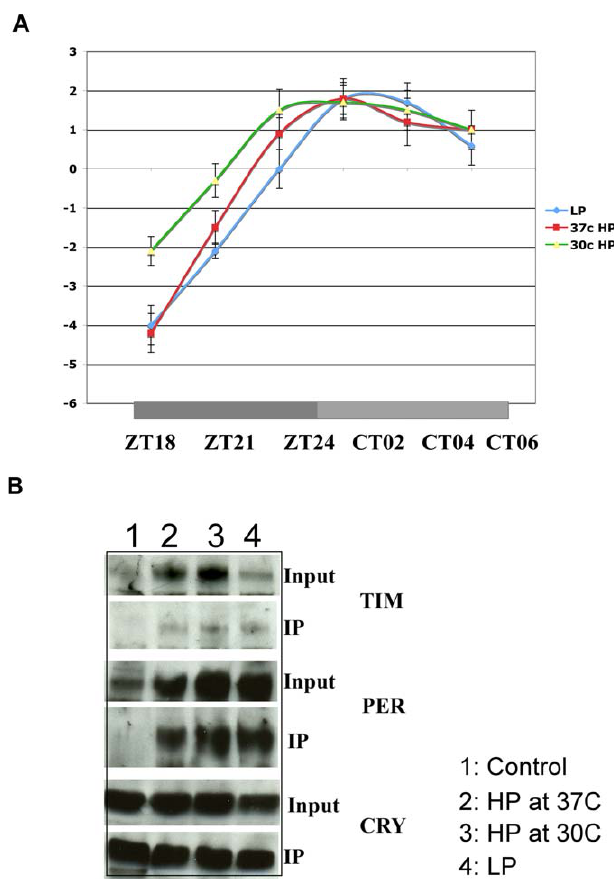
Figure 4. per L Is Hypersensitive to Heat Pulses Phase response curves are shown for per L flies, after a heat pulse at 37 8 C (square), after a 30 8 C heat pulse (diamond) or after a light pulse (circle). The experiment was performed as described in Figure 1A and repeated twice with similar results. Phase delays and phase advances are plotted ( þ /- SEM) as negative and positive values, respectively. Data were pooled from the following number of flies (each set of values referring to per L light pulsed, heat pulsed at 30 8 C or 37 8 C): control: 32, 32, 32; pulse at ZT18: 26, 32, 29; pulse at ZT21: 19, 32, 31; pulse at ZT24: 27, 31, 27; pulse at CT02: 30, 31, 22; pulse at CT04: 32, 29, 21. (B) per L ; TMC flies (see above) were entrained to 12:12 light:dark conditions and heat pulsed at 37 8 C (2) heat pulsed at 30 8 C (3), light pulsed (LP) (4) or not (1) for 30 min all at CT02, collected, and frozen. CRY, PER and TIM levels were measured by Western blotting after anti-MYC immunoprecipitation (IP) from head extracts (HE). Heat- and light-dependent interactions among CRY, TIM, and PER were assayed three times with essentially indistinguishable